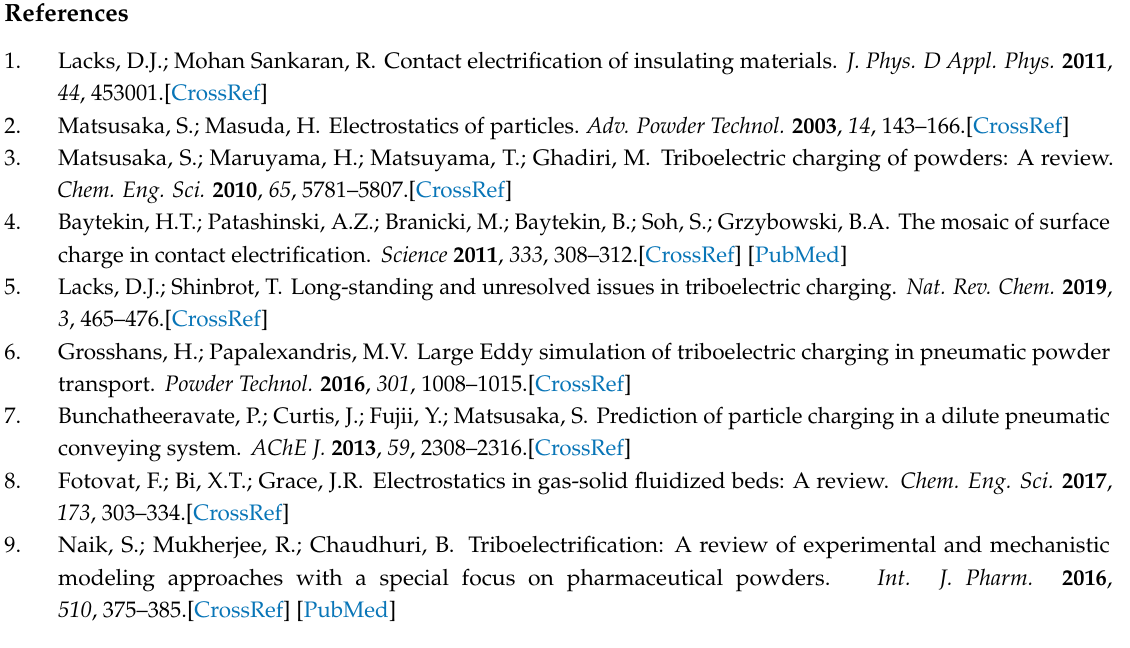
s1. Figure S1: Sensitivity analysis of Equation (2) to estimate the influence of turbulence eddy dissipation rate and protein content in the initial powder (from 0.99 to 0.01) on the contact number. Contact numbers and turbulent eddy dissipation rates used in this study are